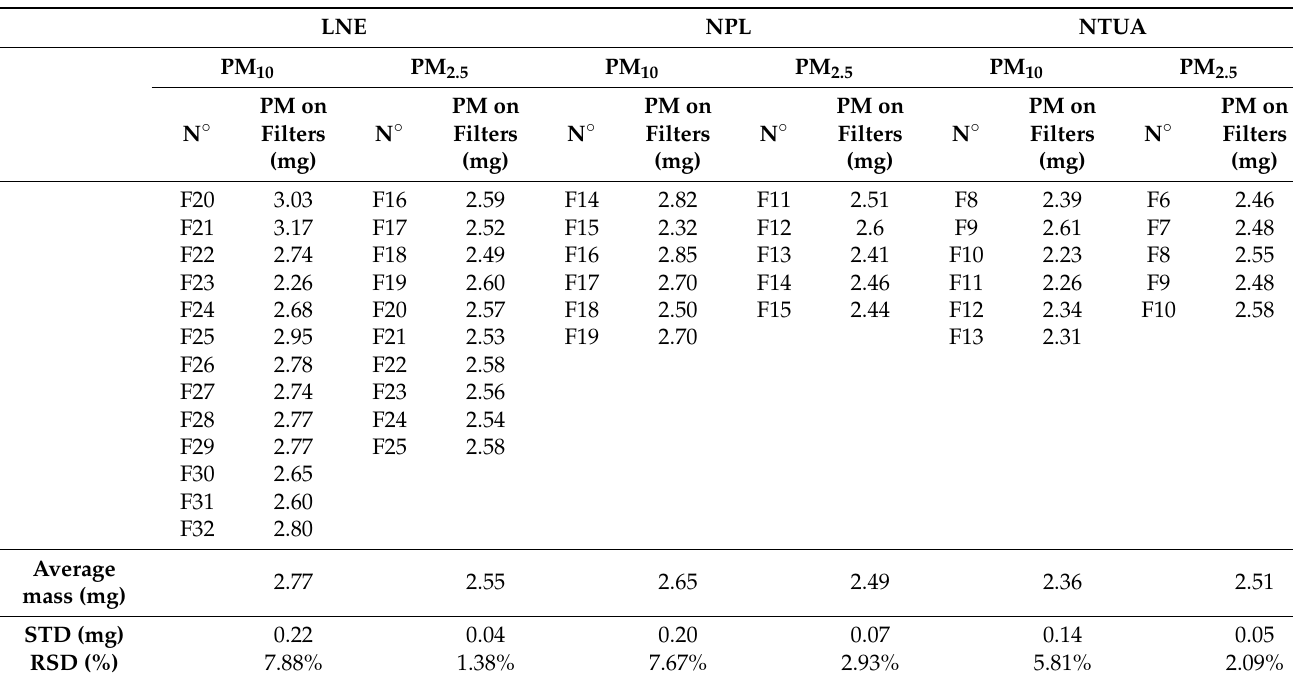
Table A1. Particulate mass load on the filters for all laboratories during this intercomparison.